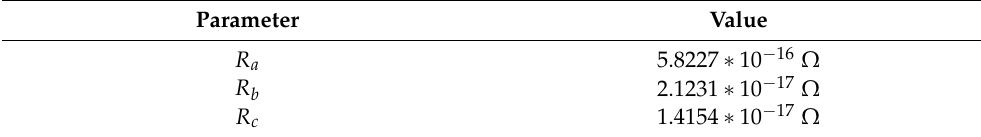
Table 7. Capacitive–Resistor Model’s Parameters (2 h, r).